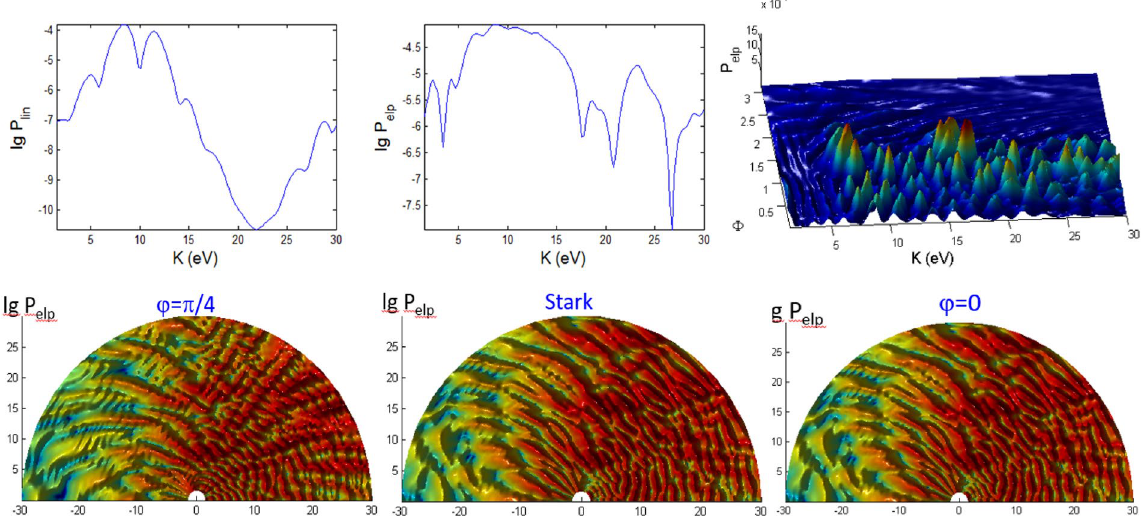
Figure 10. Same as Fig. 9 (versus angle Φ with t p = 10 fs) but for case B.